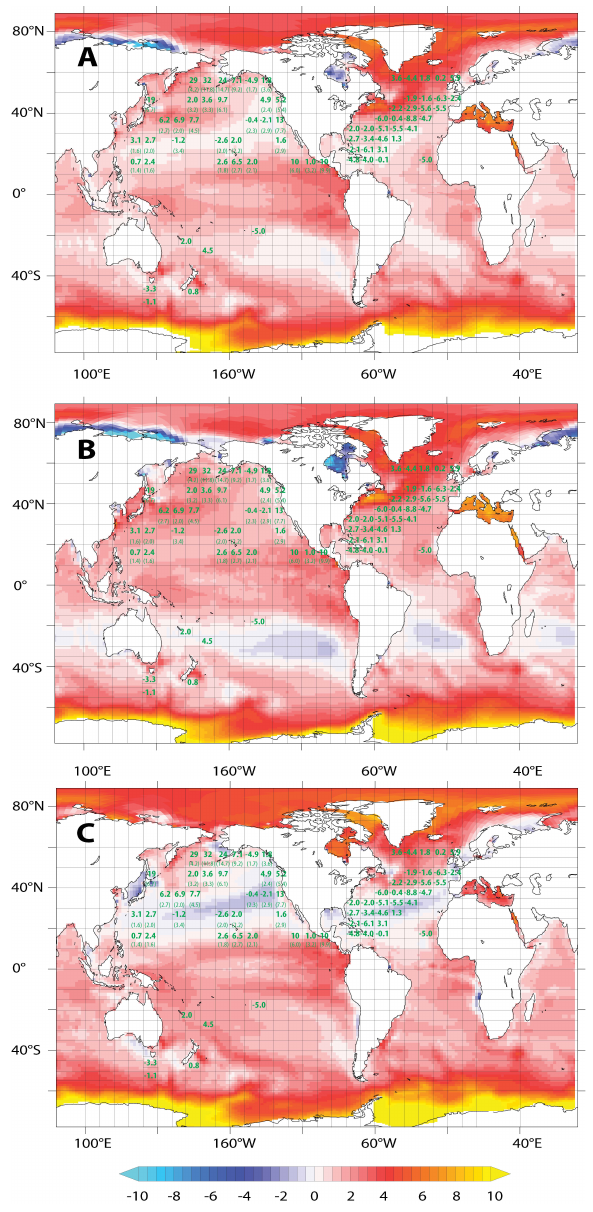
Fig. 1. (A) Decadal trends in the annual mean of 1p CO 2 over 1970–2000 (µatm decade − 1 ) computed from the annual mean of DIC, SST, Alkalinity and Salinity. (B) Decadal trends of 1p CO 2 for February over 1970–2000 (µatm decade − 1 ) computed from the DIC, SST, Alkalinity and Salinity in February. (C) same as B but for August (i.e. computed from the DIC, SST, Alkalinity and Salinity in August). The numbers in bold green letters indicate the decadal trends of 1p CO 2 computed from Takahashi et al. (2006) and (2009) assuming a 1.5µatmyr − 1 increase of the atmospheric CO 2 concen- tration over 1970–2000. The values in parenthesis indicate the un- certainty in the same unit. In boxes without parenthesis numbers, uncertainty ranges from 1 to 6µatm decade − 1